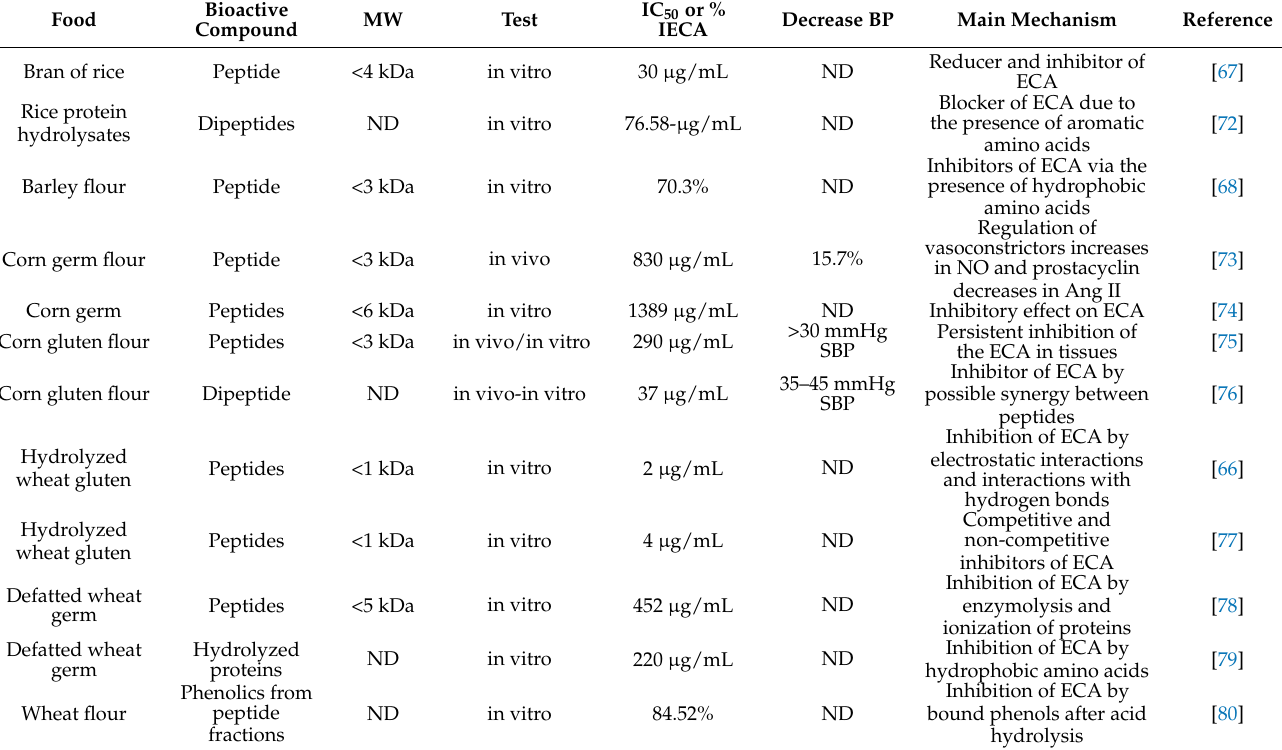
Table 2. Peptides derived from cereals with antihypertensive